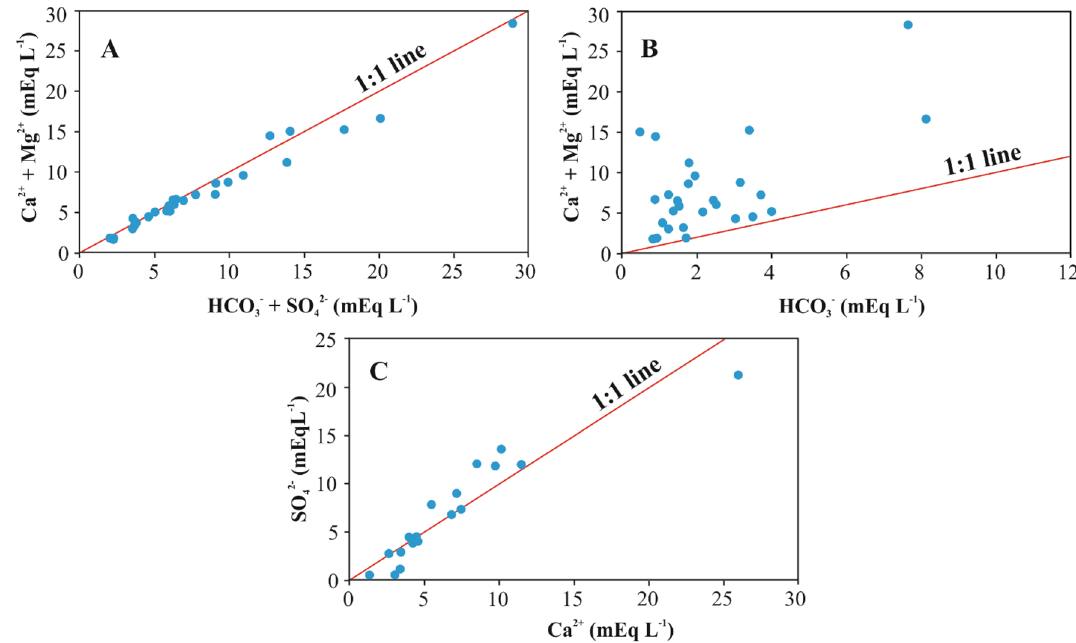
Figure 6. Distribution Ca 2+ + Mg 2+ vs HCO 3 − + SO 4 2− ( A ), Ca 2+ + Mg 2+ vs HCO 3 − ( B ), SO 4 2− vs Ca 2+ ( C ). Figures were created using Grapher (17.2.435, www. golde nsoft ware.